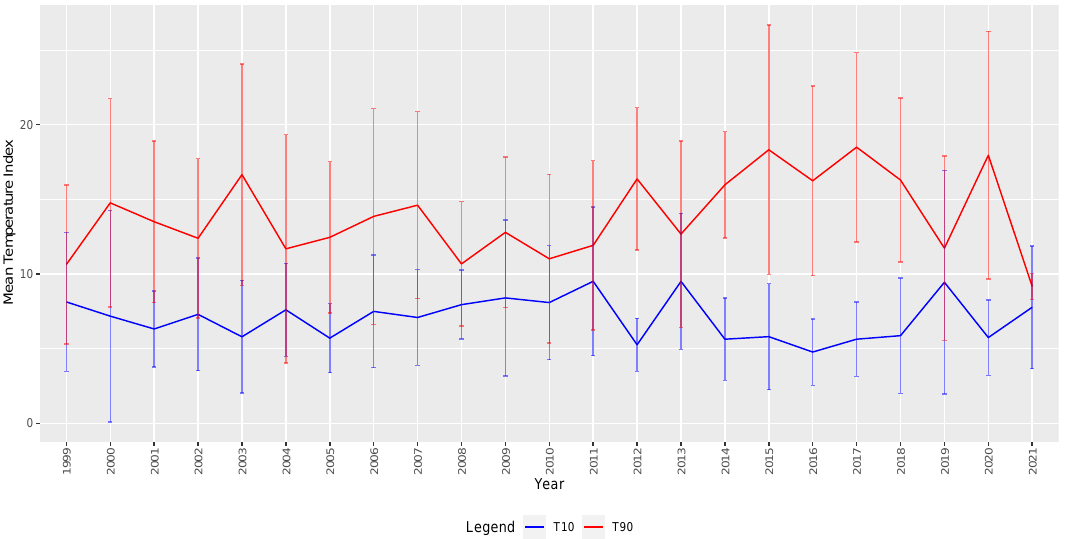
Figure 3. A plot of T90 and T10 for the Southwest Pacific Region over the period 1999 to